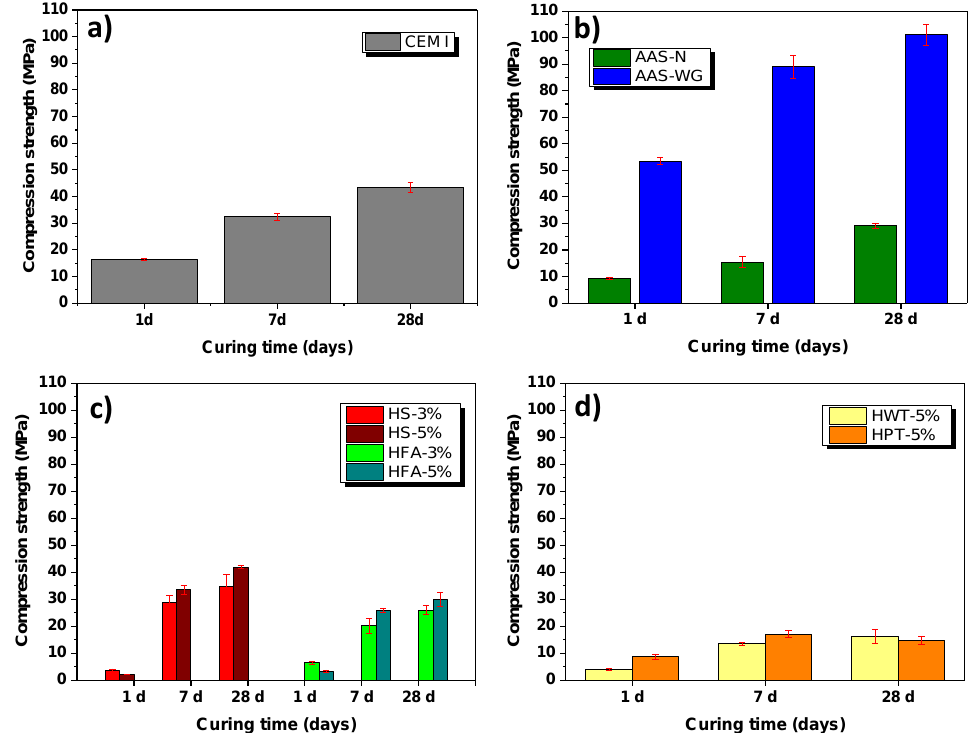
Figure 3. Compression strengths of mortars at different curing ages (1, 7 and 28 days): ( a ) Portland cement (CEM I); ( b ) alkaline-activated slag with 4M NaOH (AAS-N) and with sodium silicate solution (AAS-WG); ( c ) hybrids cements with blast furnace slag (HS-3% and HS-5%) and with fly ash (HFA-3% and HFA-5%); ( d ) hybrid cements with porous waste (HWT) and with porcelain waste (HPT).